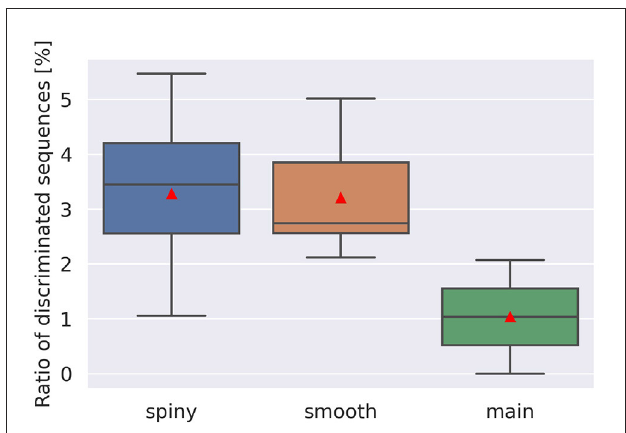
FIGURE6 Ratio of discriminated sequences. The discriminated sequences consisted of the pulse sequences spiking in IN and OUT. Red triangles are averaged values. Note that we had only one cube for main dendrites, where stimulation started from compartment number 1,573, whereas for spiny and smooth dendrites, the cube numbers were 13 and 7,